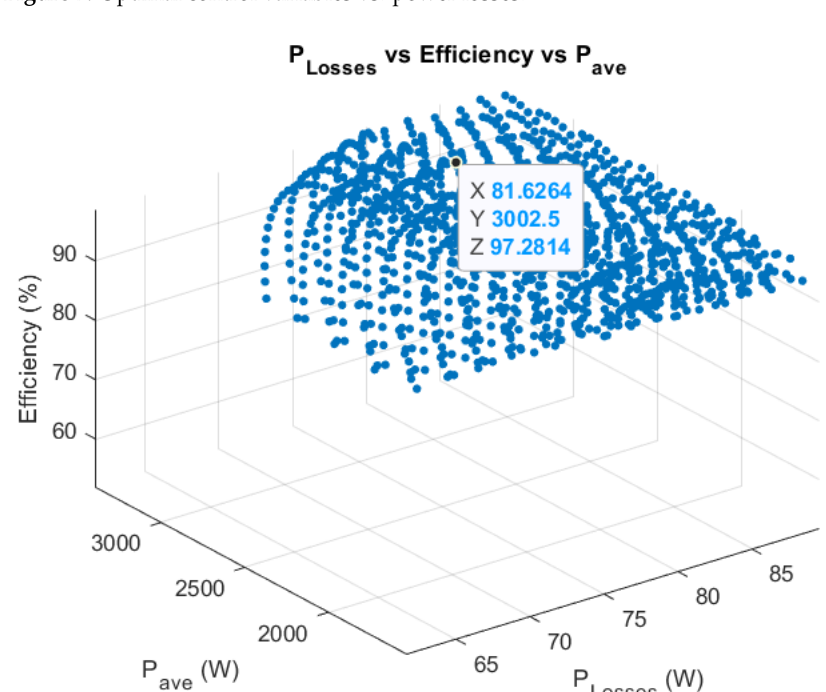
Figure 8. Analytical average power, efficiency, and power loss